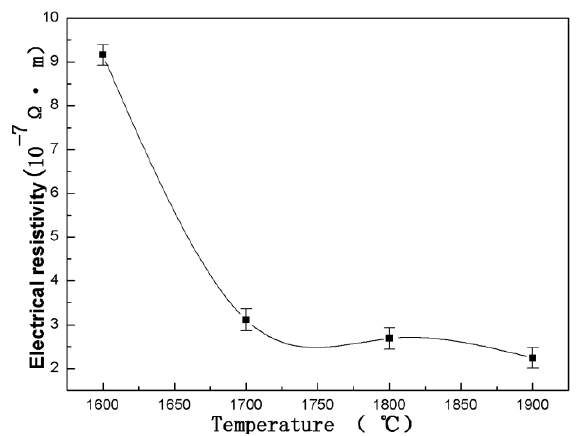
Figure 6. The variation of electrical resistivity with temperature for WB 2 synthesized at 5.2 GPa and temperatures of 1600 ℃ to 1900 °C for 15 min.